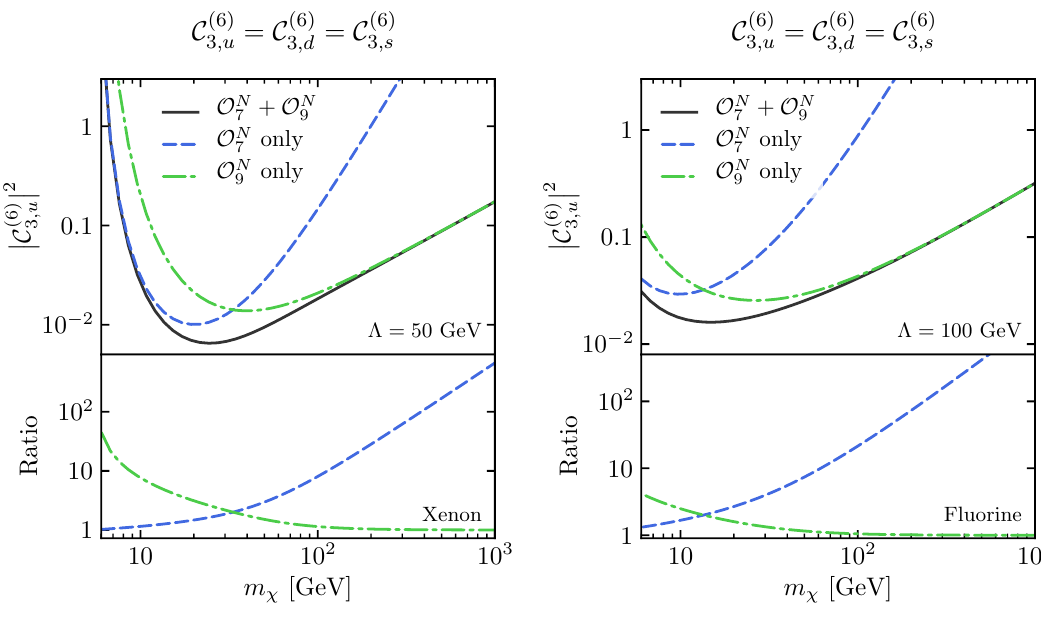
(6) = ((cid:22) (cid:31)(cid:13) (cid:22) (cid:31) )((cid:22) q(cid:13) (cid:22) (cid:13) 5 q ) operator 3 ;q Q N (dashed blue 7 O